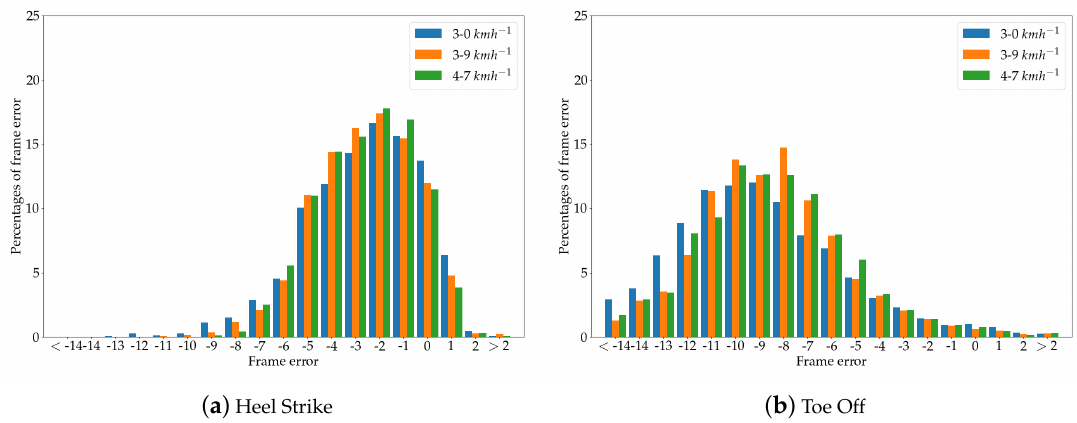
Figure 8. Gait event timing of Azure Kinect with respect to the Vicon reference